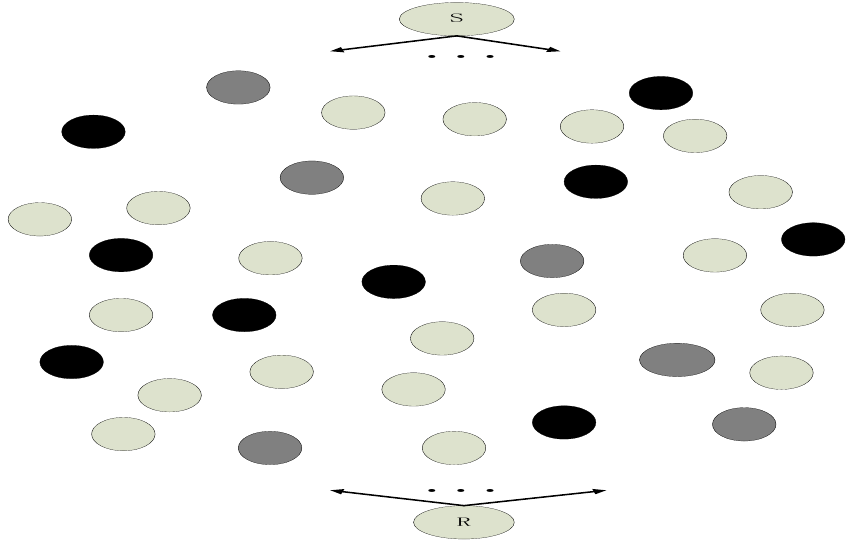
Figure 6. Parts of intermediate nodes performing network coding in WSN. The highest trust value nodes with black, the median value nodes with gray, and the lowest trust value nodes with the white.